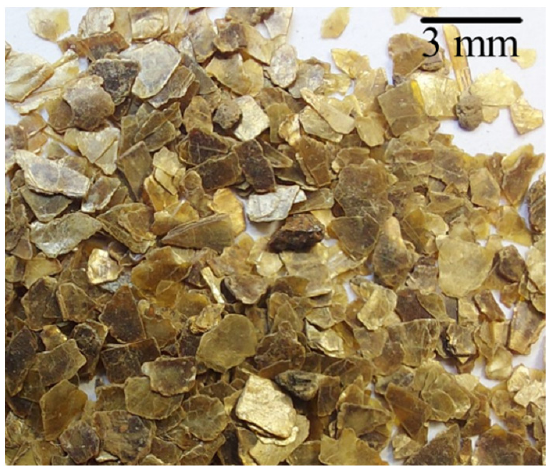
Figure 1. Aspect of raw